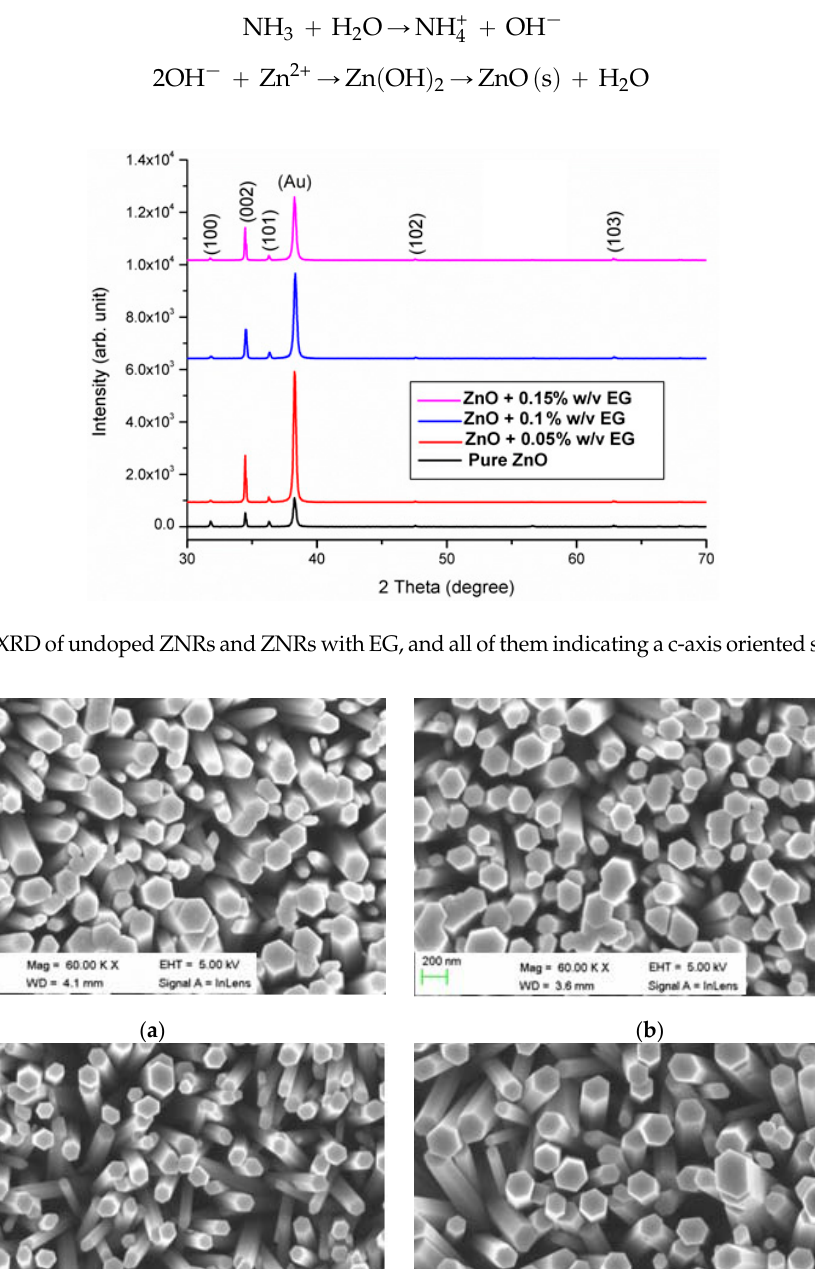
Figure 2. SEM of ( a ) pristine and doped ( b ) with 0.05, ( c ) 0.1, ( d ) 0.15% (w/v) of EG.